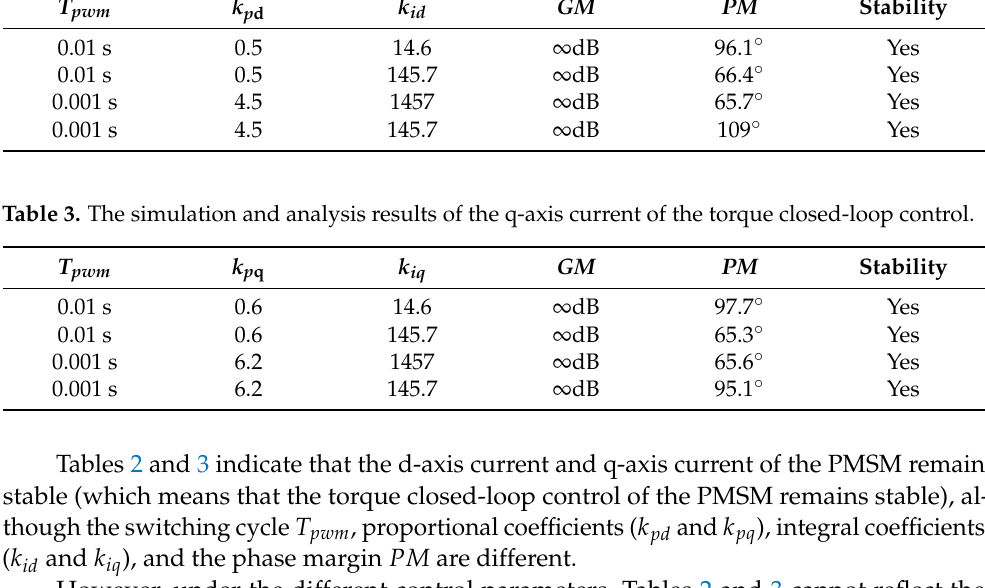
Table 2. The simulation and analysis results of the d-axis current of the torque closed-loop control. T pwm k p d k id GM PM Stability